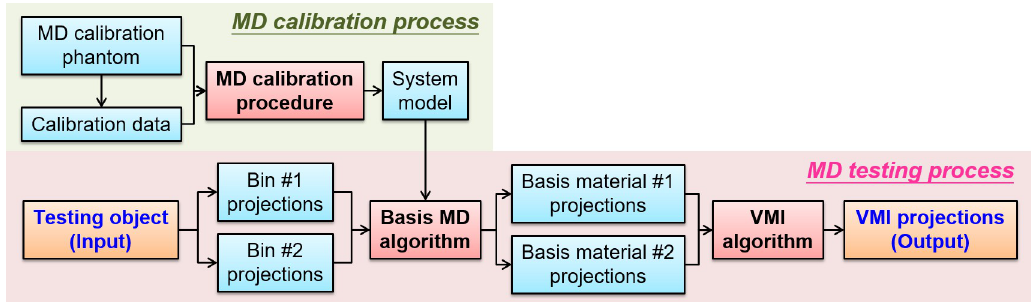
Fig 1. Scheme of VMI synthesis for MAR using projection-based MD